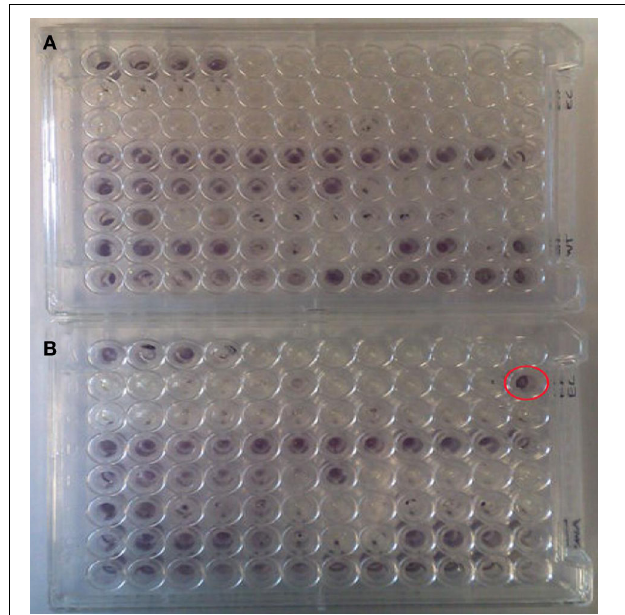
FIGURE 2 | Appearance of PM 9 plates after incubation for 24 hours at 37 ◦ C. (A) Control EPI300::pCC1FOS and (B) SMG 9. PM plates measure cellular respiration colorimetrically via reduction of a tetrazolium dye with electrons from NADH generated during the process of respiration. Strongly metabolized substrates generate a more intense purple color. Development of a strong purple color can be seen in well B12 in Figure 2B (circled in red), which was inoculated with SMG 9, while no color development is visible in B12 of the control plate. This indicates SMG 9 has a greater ability to transport and utilise L-carnitine compared to the EPI300::pCC1FOS host